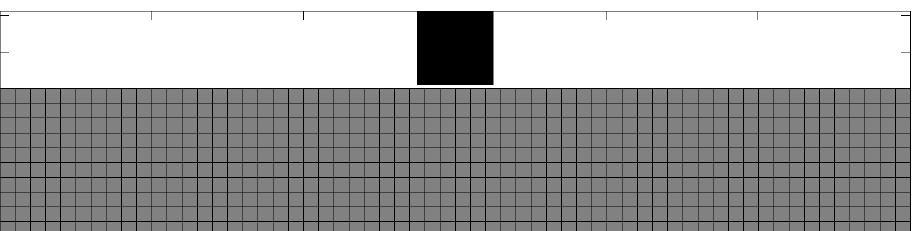
Figure 11. Deformed configuration for beam with flying block.